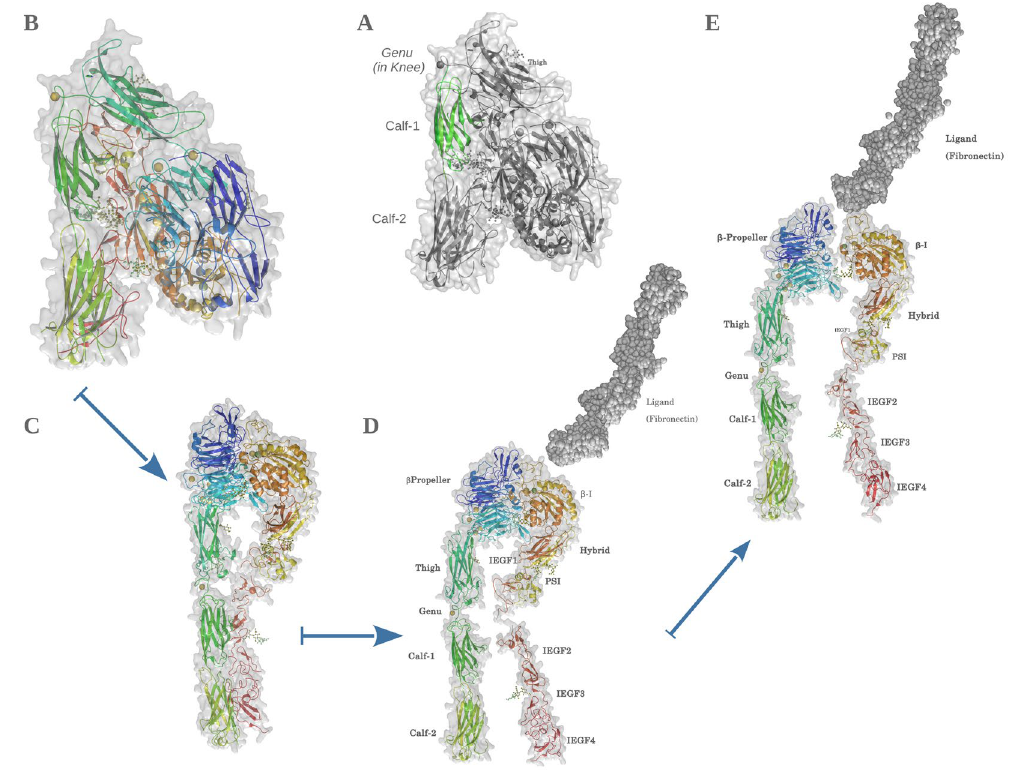
Figure 1. Closed to open transition of α IIb β 3 . ( A ) The closed form of α IIb β 3 ectodomain, with Calf-1 domain highlighted in green. Rest of the structure is depicted in dull grey to bring clarity. Structural organization of ectodomain is labelled. The rainbow schema of colours on secondary structures represents the α IIb β 3 structure. Regions in green-blue spectra mark the α IIb subunit and yellow-red spectra mark the β 3 subunit. ( B ) Closed inactive form of α IIb β 3 . The structure is bent along the plane of knee domains. ( C) Extended α IIb headpiece with β 3 leg resting alongside the α IIb leg. ( D ) Extended β 3 conformation: The β 3 headpiece has intrinsic conformational changes at C-terminus leading to an outward pull of the β 3 leg. ( E ) Extended α IIb β 3 conformation: In the last stage, β 3 headpiece pulls out creating a ligand-binding cavity between the two headpieces. Mg ++ constituting MIDAS can be seen as a green sphere in the cavity, while the ligand Fibronectin (dull grey dots) approaches the glycoprotein. All metal ions are shown as solid spheres with golden representing Ca 2 + while green representing Mg 2 + . Polysaccharides (N-acetyl glucosamines and Mannose) are shown in ball and stick representations. Please notice that the open forms had been modelled from the closed structure according to expected conformations using Modeller_v_9.16 and images are generated by